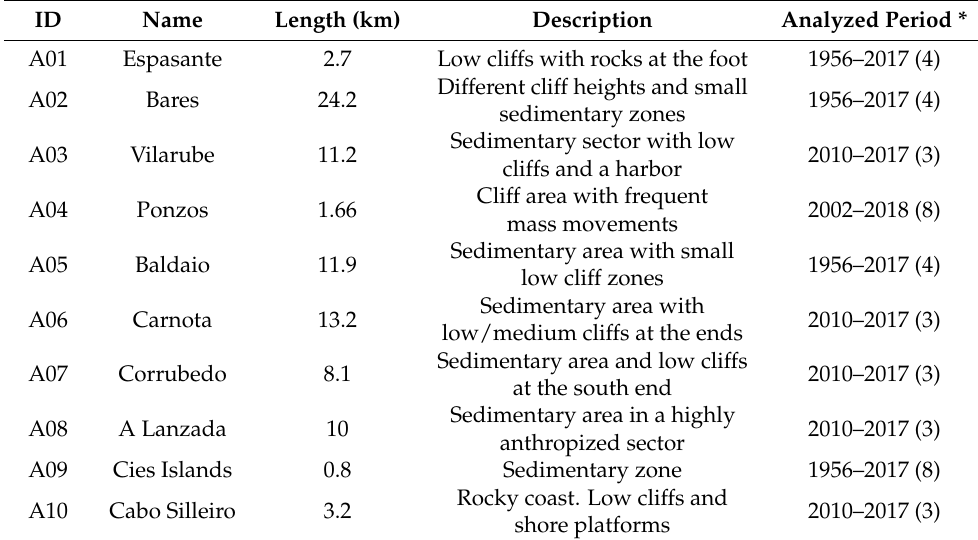
Figure 2. Location maps of the study area: ( a ) location of the NW Iberian Peninsula; ( b ) study sites are distributed across the Galician coastal regions; ( c ) the red polygons indicate the ten study sites, and the black dots, the main cities. Table 1. Study sites, with their codes, names, and main